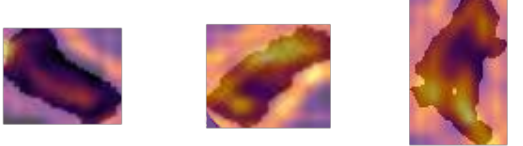
Figure 6. Type V nodule shapes and contours colorized by